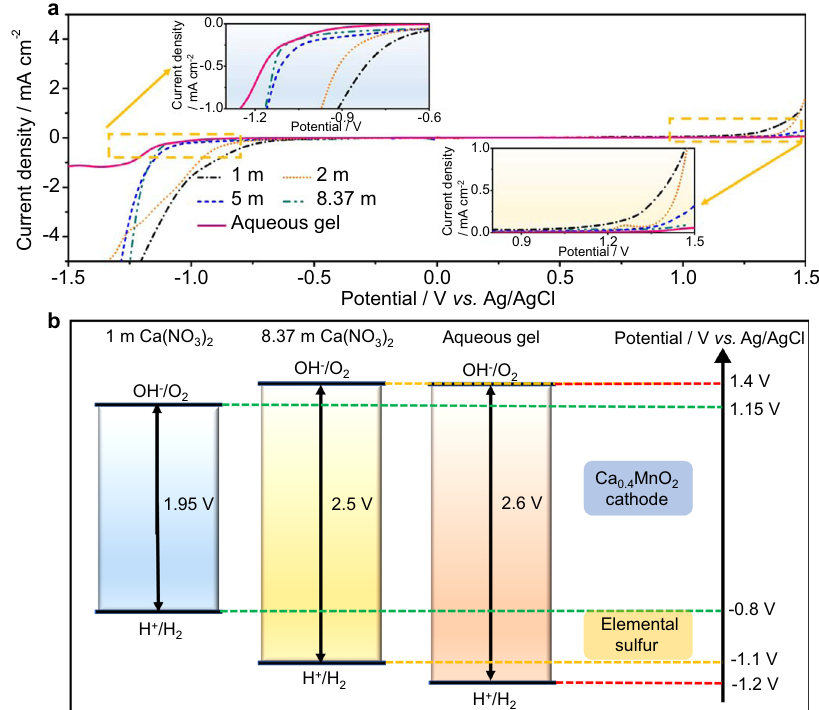
Fig. 1 The electrochemical stability window of electrolytes. a Linear voltammetry curves recorded at 1 mV s – 1 in 1 m, 2 m, 5 m, saturated (8.37 m) Ca (NO 3 ) 2 electrolytes and aqueous gel electrolyte. The insets are the magni fi ed views of the regions marked near anodic and cathodic extremes. b The electrochemical stability windows of electrolytes, and the redox voltages of Ca 0.4 MnO 2 cathode and sulfur anode obtained from experimental